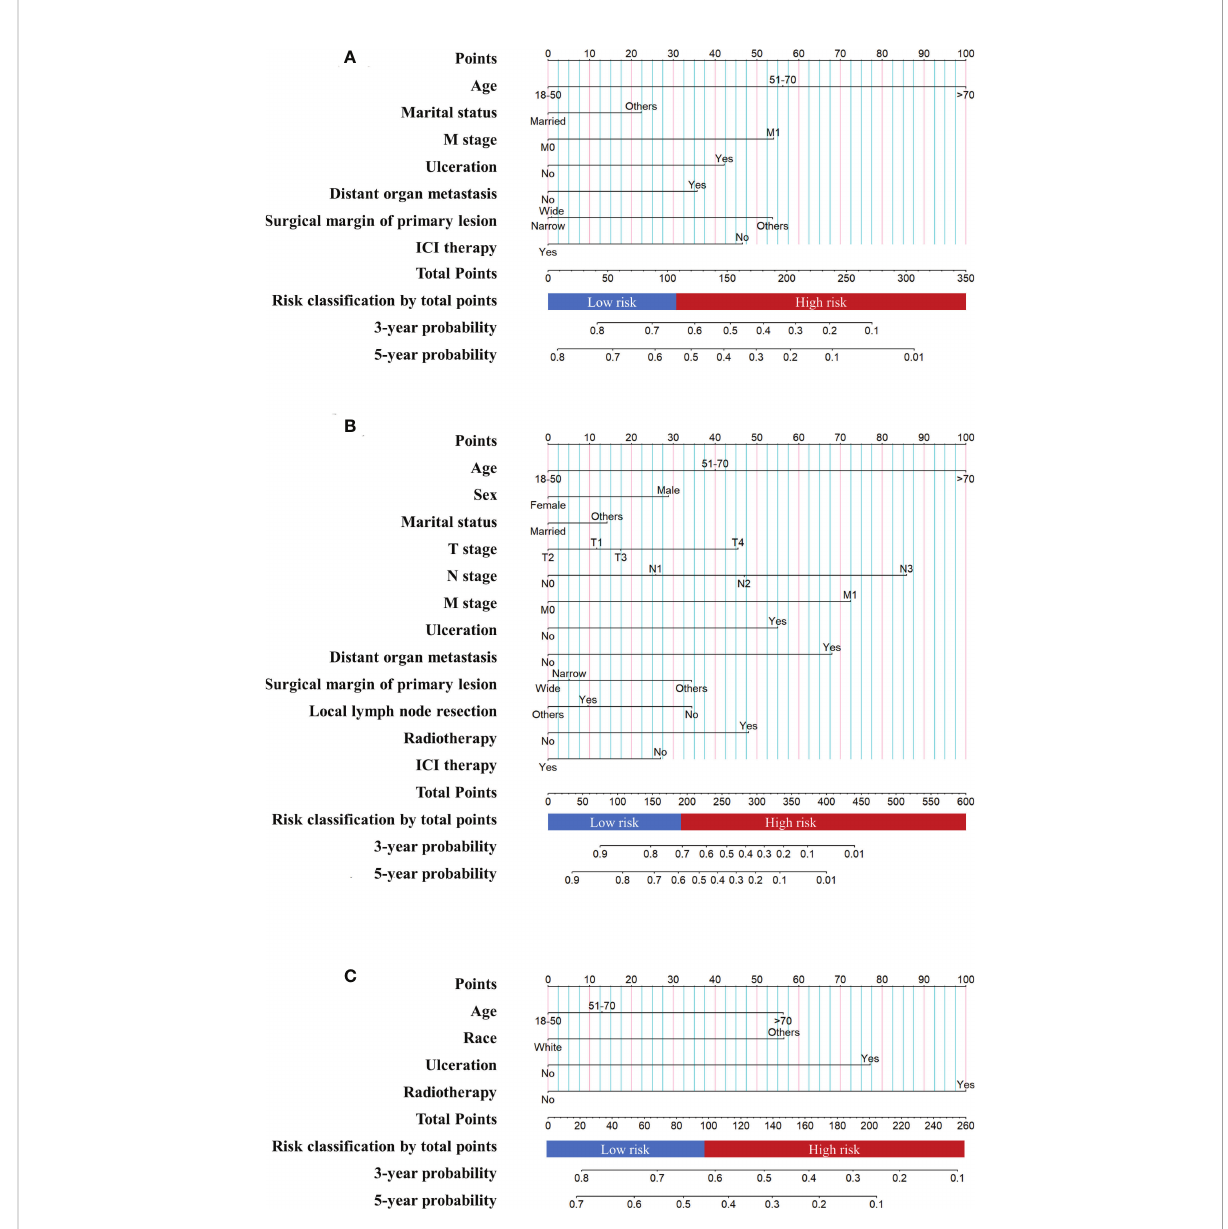
FIGURE 4 Prognostic nomograms of metastatic melanoma (A) The nomogram of the fi rst cohort. (B) The nomogram of the second cohort. (C) The nomogram of the third